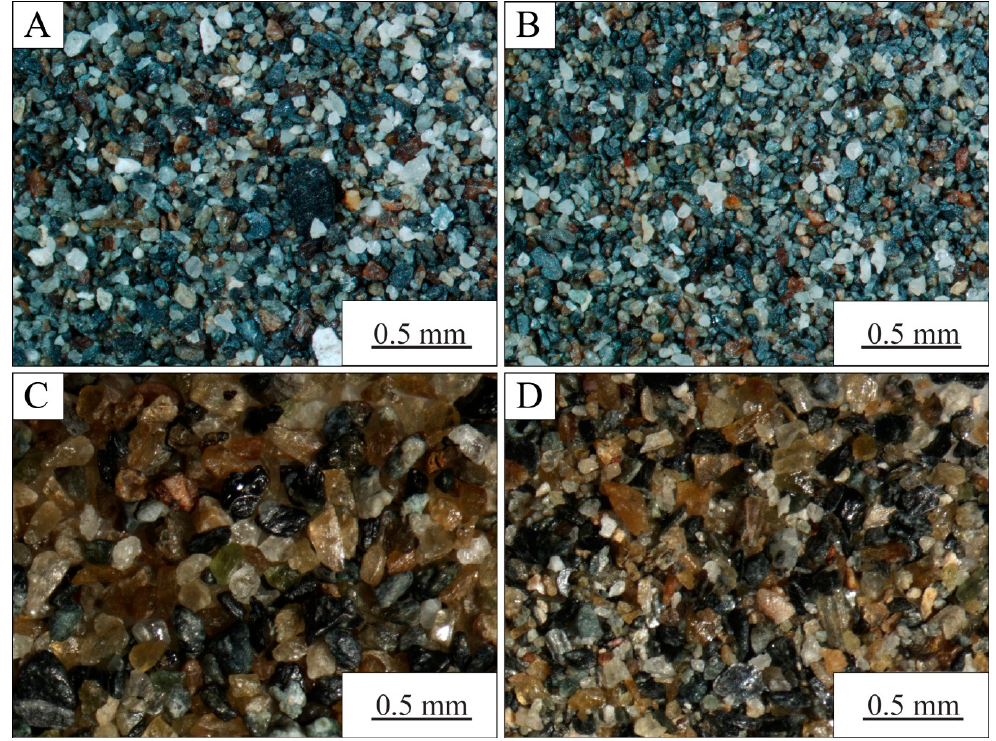
Figure 3. Beach sediments from Waropen Regency. ( A ) and ( B ) the southern region samples, dominantly pyroxene and amphibole. Stereoscopic microscope, magnification x2. ( C ) and ( D ) the northern area samples, olivine, pyroxene and chromian spinel grains. Stereoscopic microscope, magnification x4.